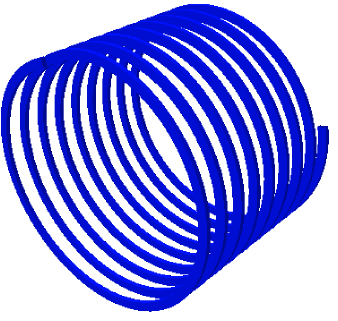
Table 3. Comparison of design parameters and performance parameters of three candidate points.